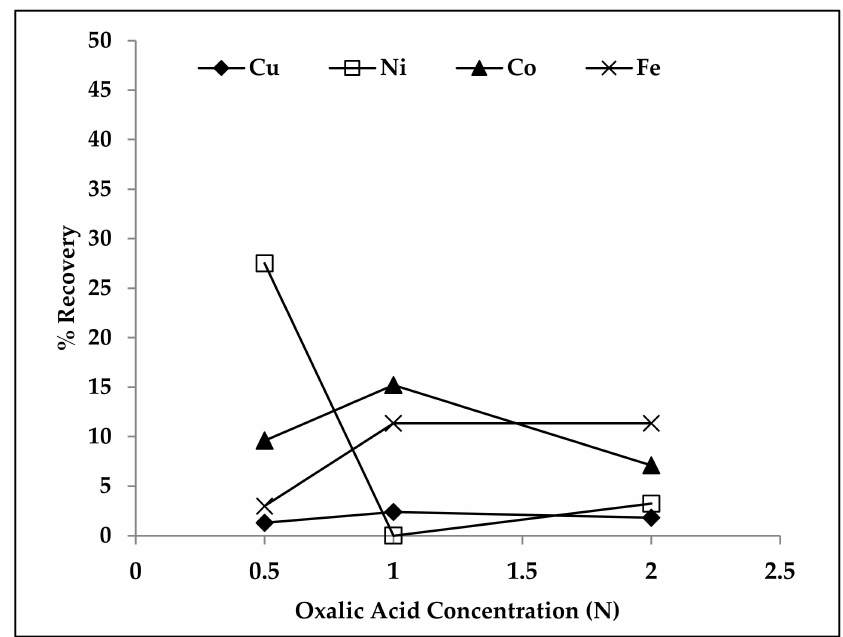
Figure 4. E ff ect of acid concentration of oxalic acid on Cu, Ni, Co and Fe recovery at 5% pulp density (PD), 308 K in 15